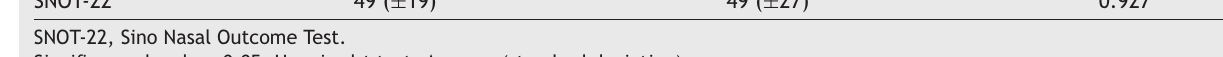
Table 2 Quality of life score with SNOT-22 of the groups. Variable Surgery group Clinical group